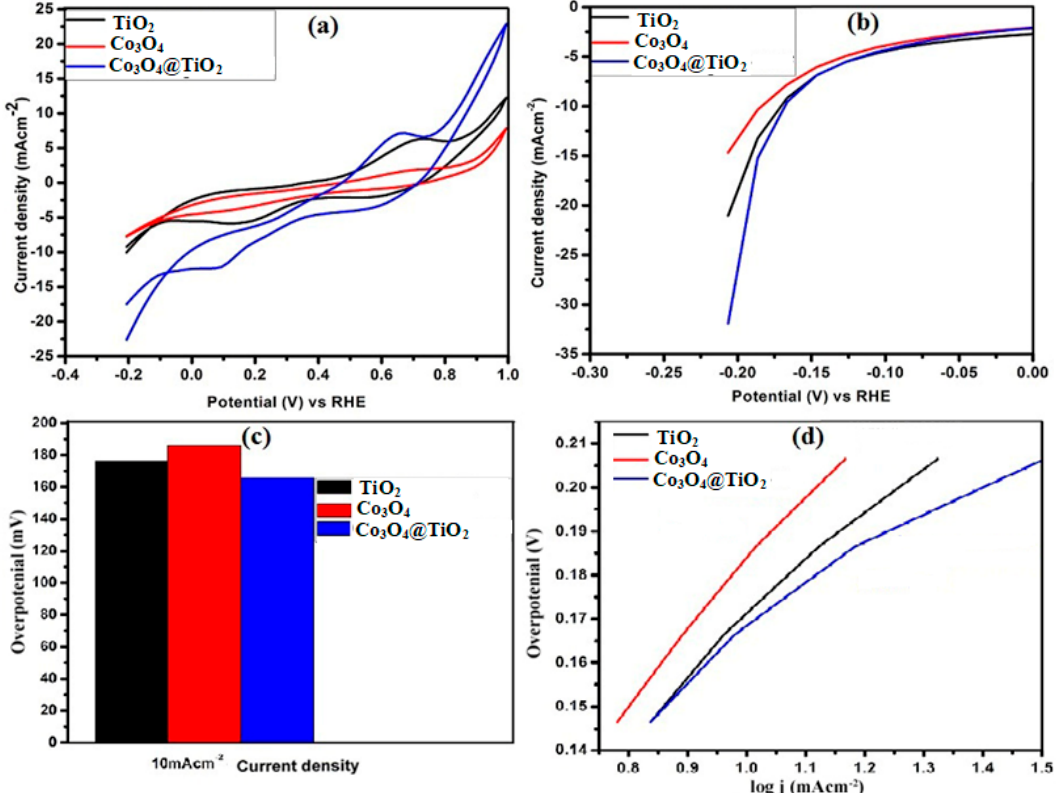
Figure 3. ( a ) CV, ( b ) linear sweep voltammetry (LSV) curves, ( c ) overpotential, and ( d ) Tafel plot of Co 3 O 4 , TiO 2 , and Co 3 O 4 @TiO 2 composite.